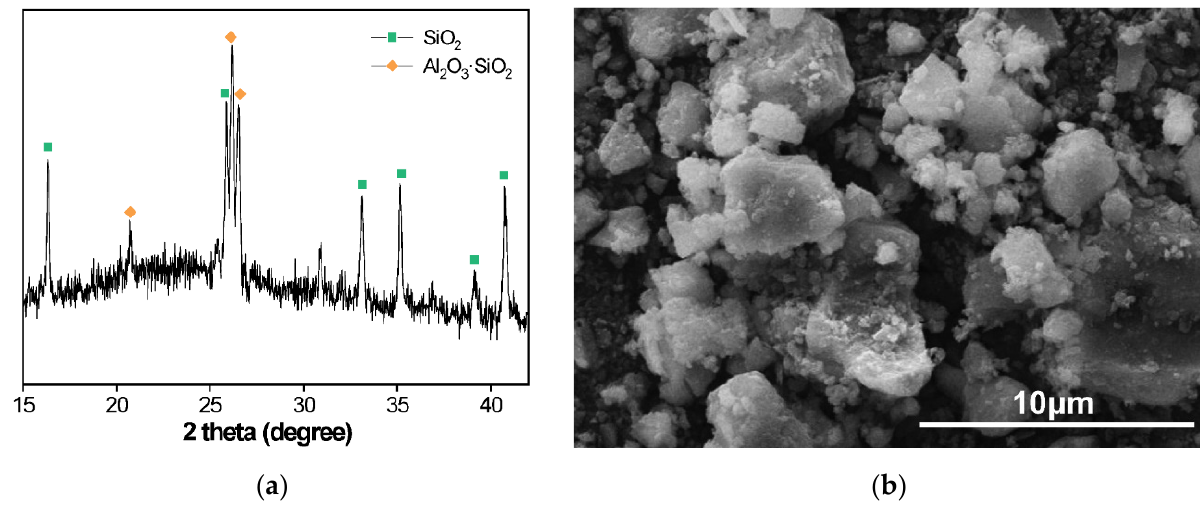
Table 2. Chemical components of raw materials.